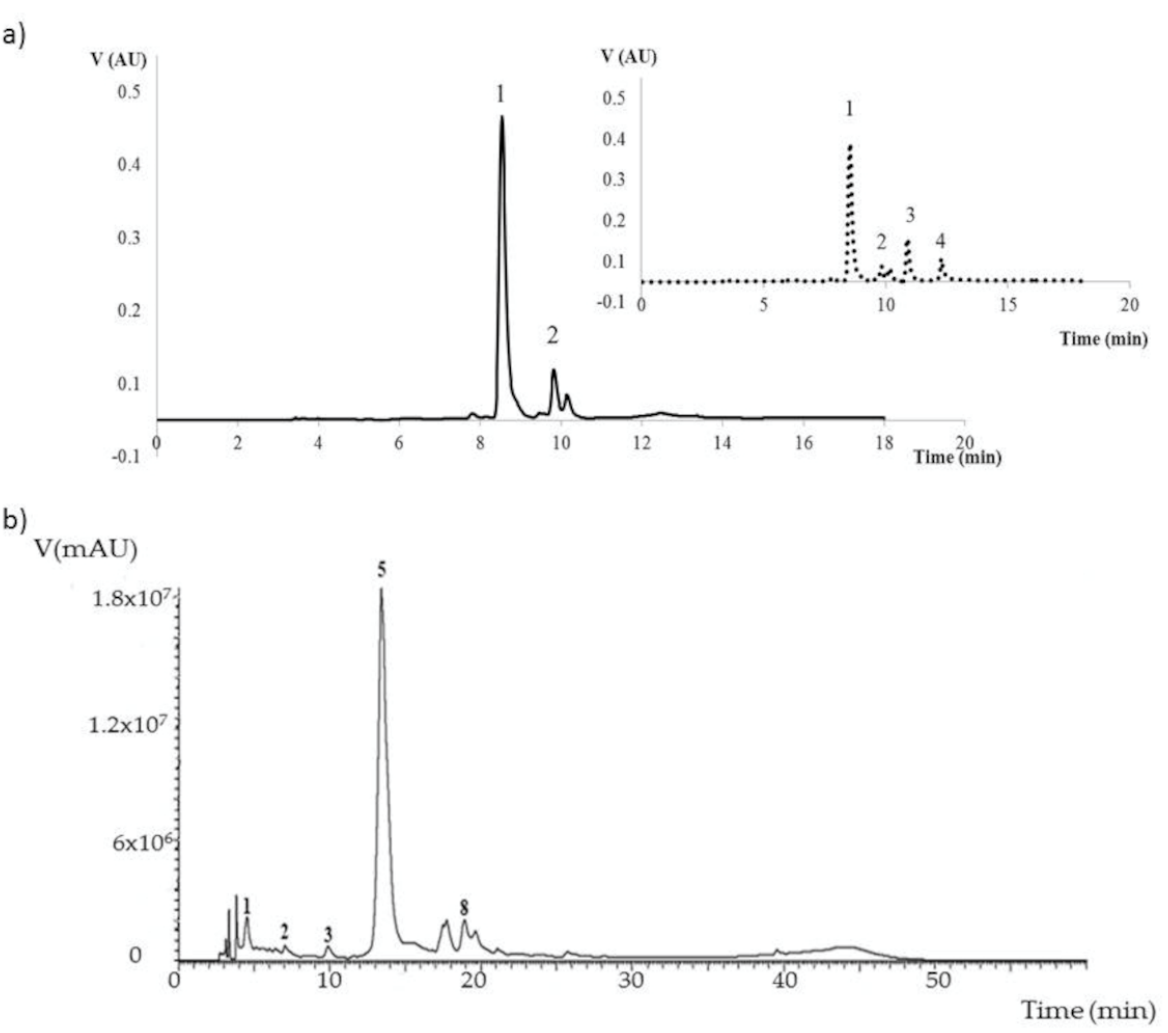
Figure 3. ( a ) HPLC profile of Riesling verjuice at 280 nm, before (continuous line) and after (dashed line) enzymatic treatment obtained in this work. Peak 1: caftaric acid, peak 2: coutaric acid, peak 3: caffeic acid, peak 4: coumaric acid. ( b ) HPLC profile (at 280 nm) of E. purpurea aerial part as reported by Coelho and colleagues [34]. Peak 1: caftaric acid, peak 2: 5- O -caffeoylquinic acid, peak 3: caffeic acid, peak 5: chicoric acid, peak 8: feruloylcaffeoyltartaric